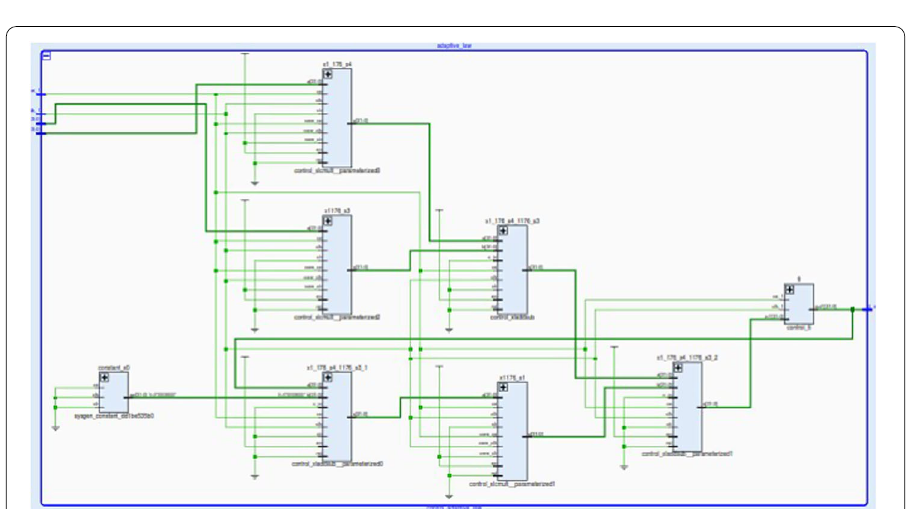
Figure 16 Xilinx RTL schematics of the parameter update